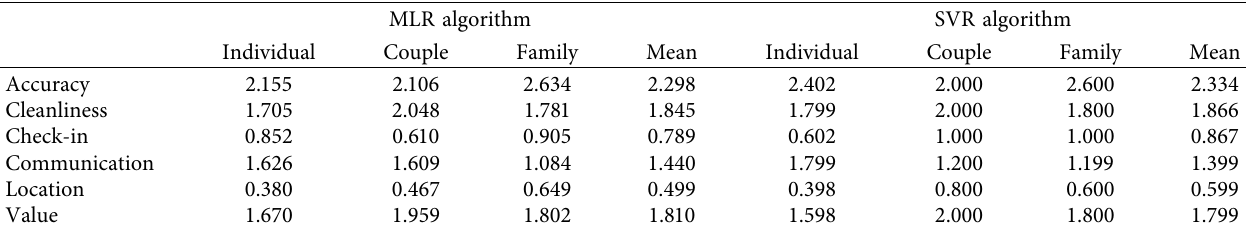
Table 2: Coefficients acting on the 6 satisfaction indicators using the algorithms MLR and